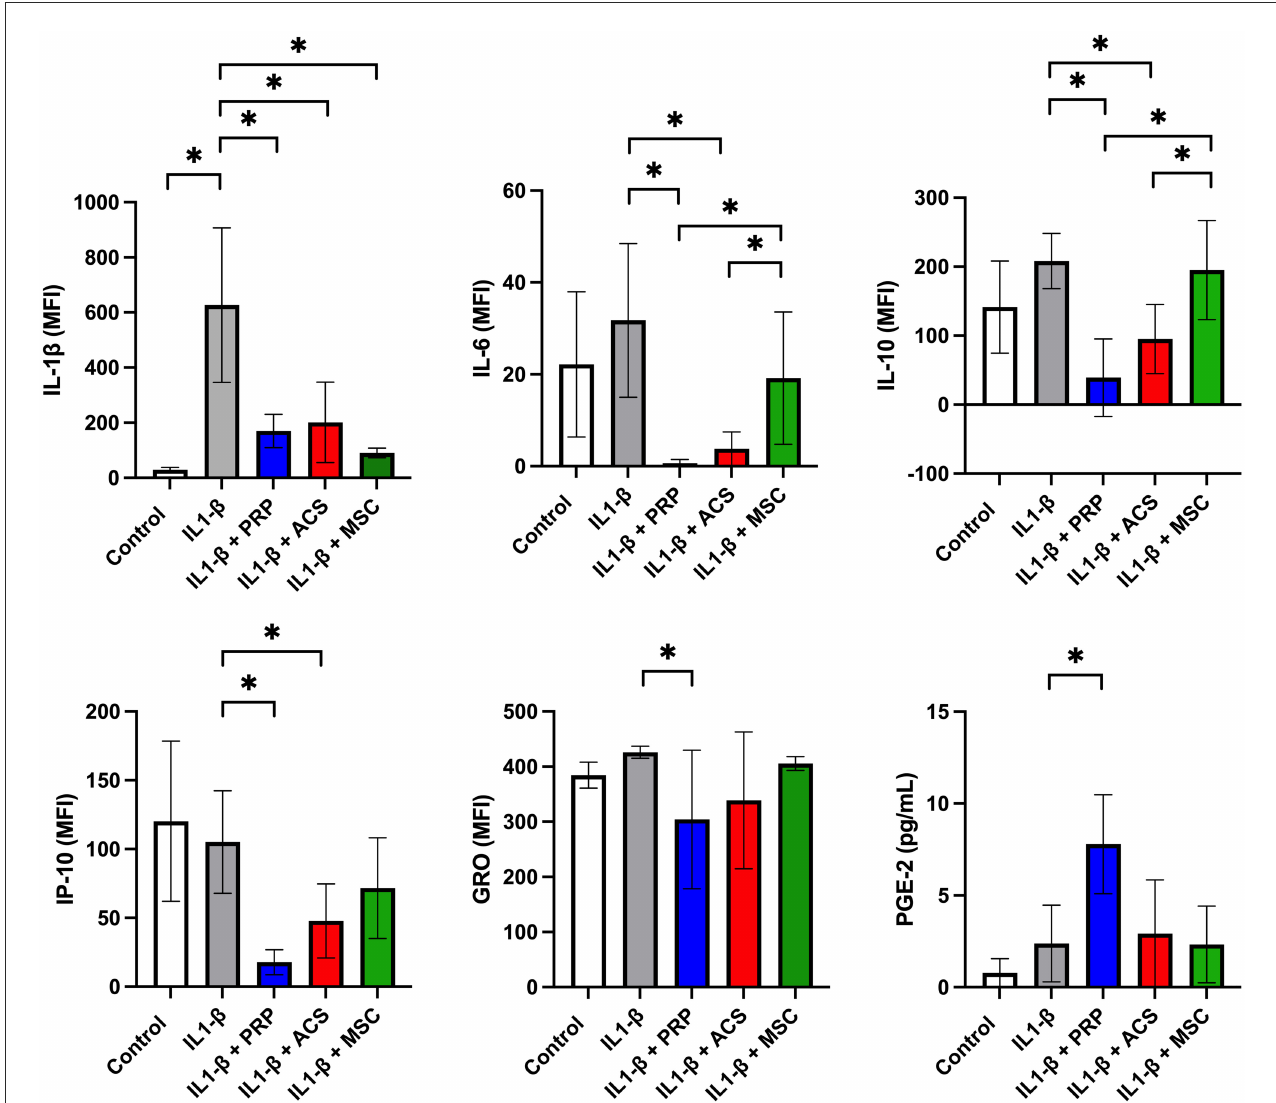
FIGURE2 Effect of orthobiologic treatment on macrophage cytokine secretion. Orthobiologic therapies (platelet rich plasma or PRP, autologous conditioned serum or ACS, or mesenchymal stromal cell conditioned media or MSC) were added to culture media with equine monocyte derived macrophages and IL-1ß (10ng/ml) for 24h. Controls included unstimulated and IL-1ß stimulated macrophages. After 24h, macrophages were washed in phosphate buffered saline and cultured an additional 24h and culture supernatants collected and assessed for cytokine levels via multiplex immunoassay (23 cytokines) and ELISA immunoassay (PGE-2 and TGF-ß). Cytokine levels were measurable for ten cytokines via multiplex immunoassay (IL-1ß, IL-4, IL-6, IL-8, IFN- γ , IP10, GRO, IL-10, TNF α , and RANTES) and for one cytokine (PGE-2) via ELISA. Significant differences were seen between treatment groups for GRO, IL-1ß, IL-6, IL-10, IP-10, and PGE-2. There were no statistical differences noted for the remaining biomarkers assessed that achieved measurable levels by multiplex assay (IL-4, IL-8, IFN- γ , RANTES, and TNF- α ). Levels of the remaining 14 cytokines assessed were below the detection limit of the multiplex assay (FGF-2, eotaxin, G-CSF, IL1 α , GM-CSF, fractalkine, IL-13, IL-5, IL-18, IL-17A, IL-2, IL-12, and MCP-1) or ELISA (TGF-ß). Bars are mean and standard deviation of three biological replicates over two time points. *Statistical significance assessed at p <